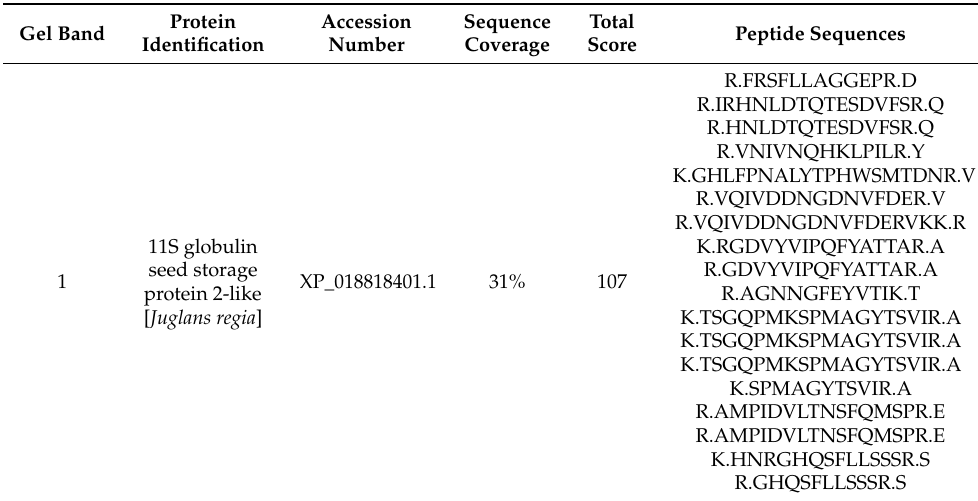
Table 3. Peptides identified by MALDI-TOF/TOF tandem mass spectrometry and the MASCOT Database Search engine. Protein scores greater than 83 were significant ( p < 0.05).